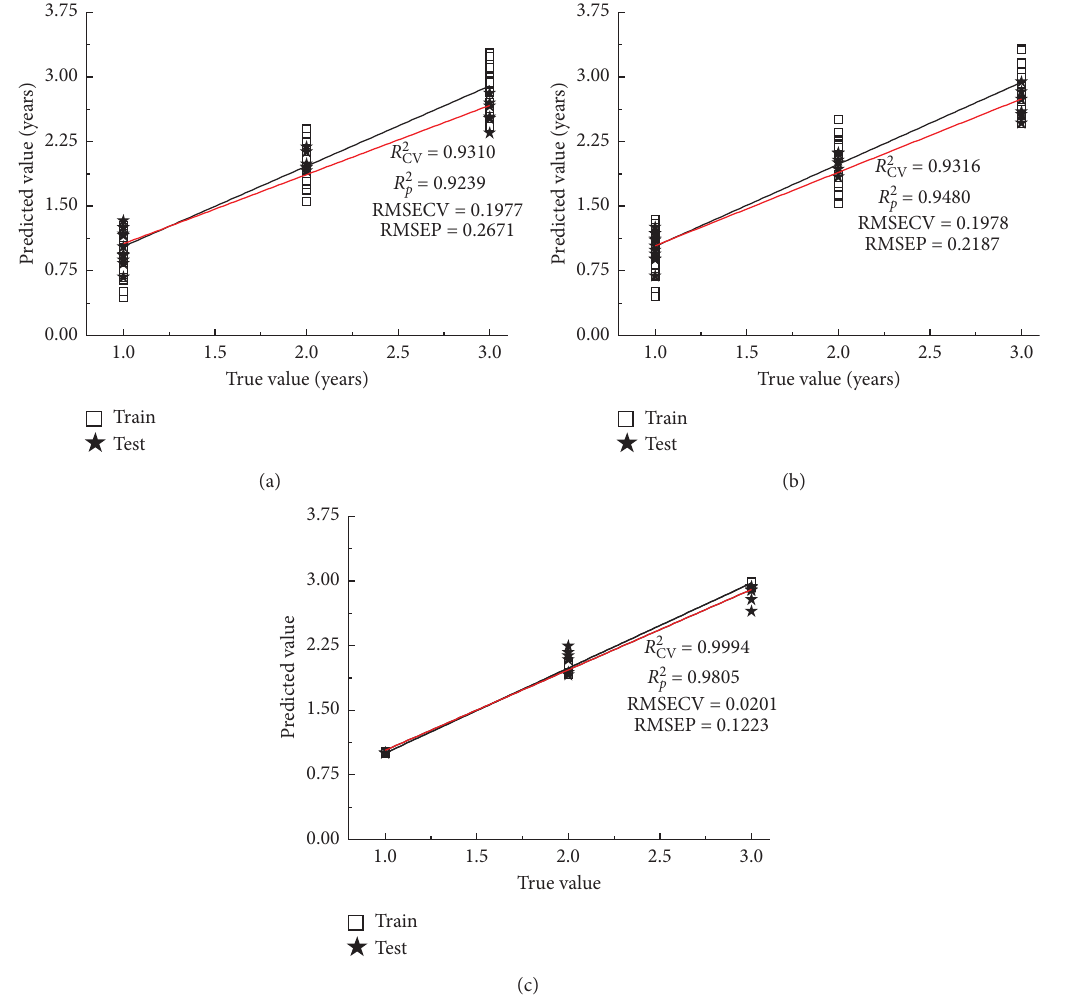
Figure 4: Prediction storage years of dried Lycium fruits by MLR, PLS, and BPNN.